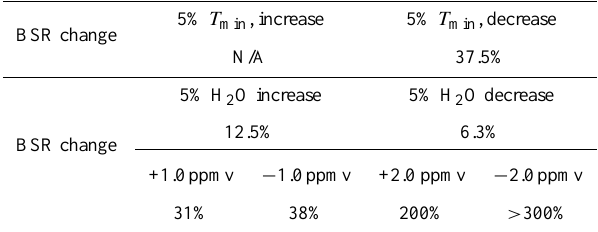
Table 1. Sensitivity of BSR to changes in the background tempera- ture and water vapour